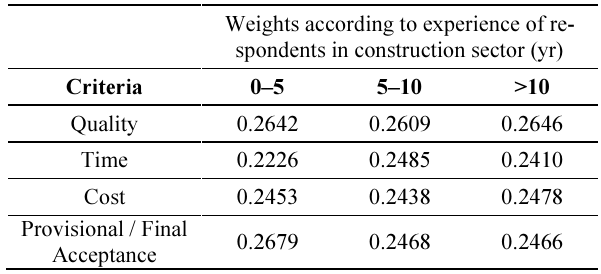
Table 1. Relative weights of main criteria according to experi- ence of respondents Weights according to experience of